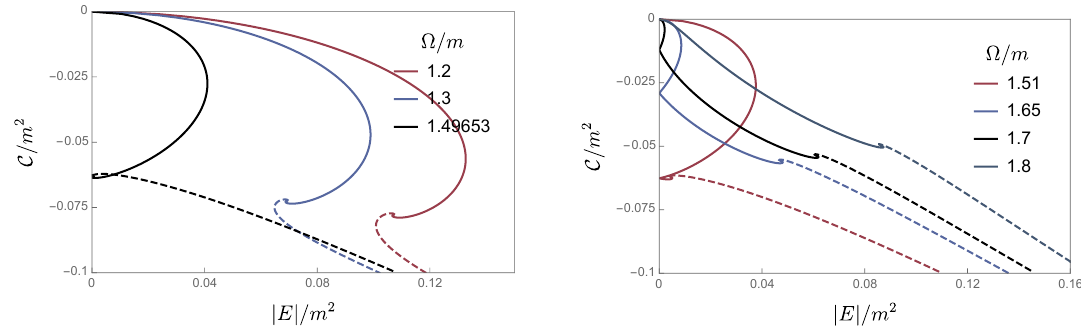
Figure 5 . Quark condensate as a function of the electric (cid:12)eld for several (cid:10) around the (cid:12)rst resonance. The curves on the left (right) are for (cid:10) (cid:20) (cid:10) c ((cid:10) > (cid:10) c ). Solid (dashed) curves correspond to Minkowski (black hole) embeddings.